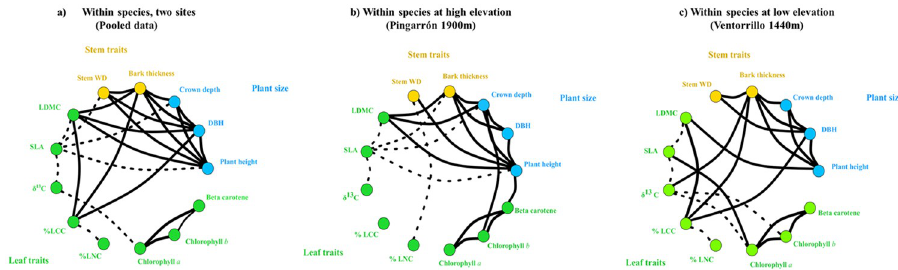
Fig 2. Correlograms of traits measured in individual Scots pines calculated with pooled data and data from both study sites separately (Pingarro´n at 1900m and Ventorrillo at 1440m). Solid lines represent positive correlations, and dashed lines negative correlations. Line thicknesses are proportional to the correlation strength. Only significant correlations are shown. Plant size traits: plant height, crown depth and DBH: Stem traits: WD and bark thickness; Leaf traits: LDMC, SLA, δ 13 C, %LCC, %LNC, Chlorophyll a . Chlorophyll b and Beta-carotene. Different colours indicate different trait clusters and their different functions (yellow: stem traits, primarily mechanical support; blue: plant size traits, primarily competitive ability; green: leaf traits, primarily resource acquisition and